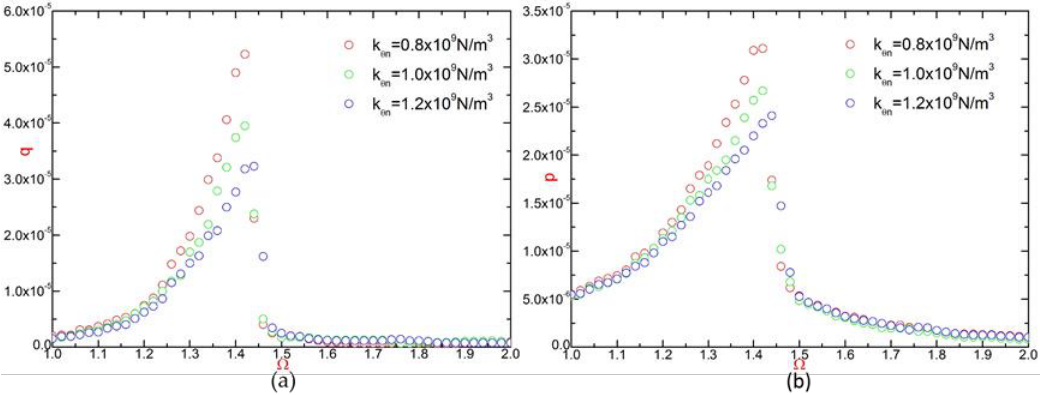
Figure 11. Influence of k θ n in 1st order generalized coodinate of the frequency response curve ( a ) in transvese direction ( b ) in rotation direction.